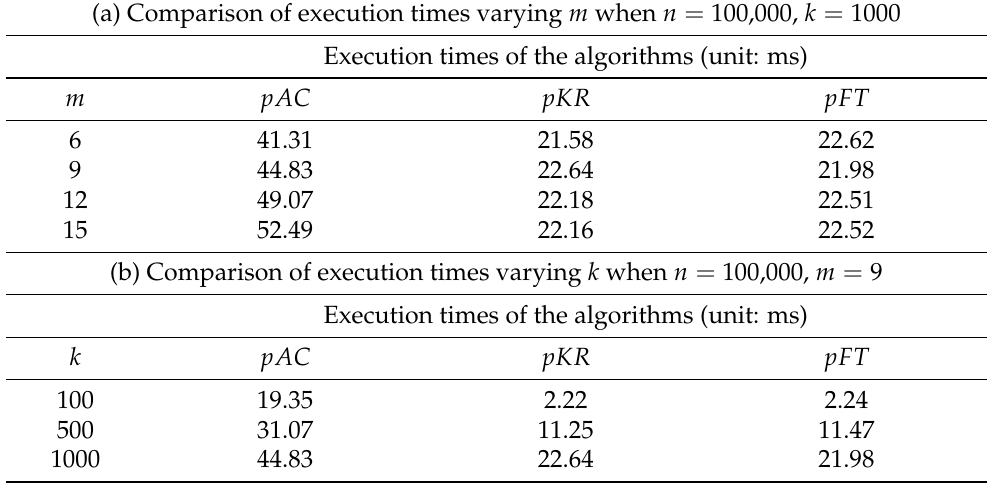
Table 2. Comparison of execution times of pAC , pKR , and pFT for random strings.